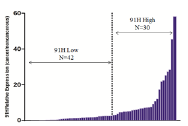
Figure 3. According to the optimal cut-off levels (2.86-fold), 72 patients with CRC were divided into two groups: $ 2.86 were considered as an elevated 91H expression group (n=30); , 2.86 were considered as a low 91H expression group.